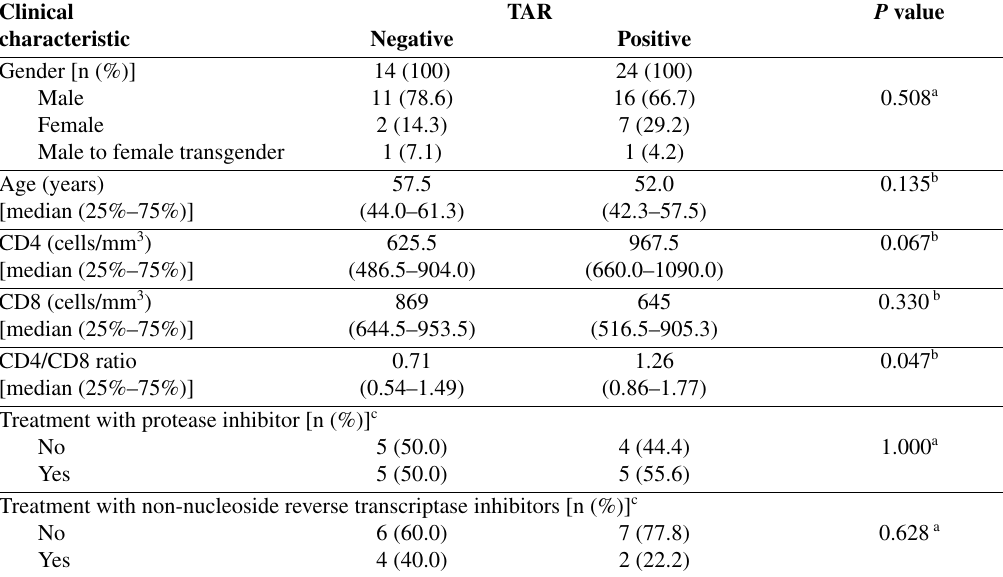
a calculated using Fisher exact tests; b calculated using Mann-Whitney tests; c only ART-suppressed